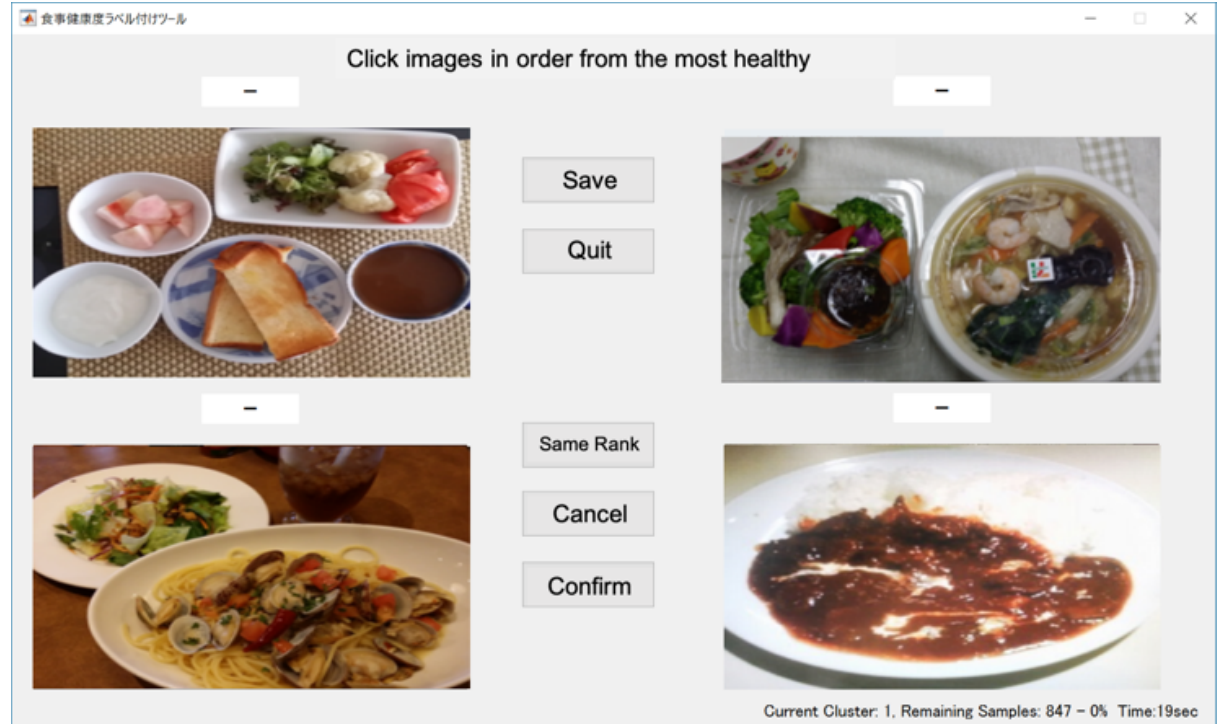
Figure 2. App interface to generate the ranking data. A set of 4 meal images is presented, and the registered dieticians rank those images from the 1st to